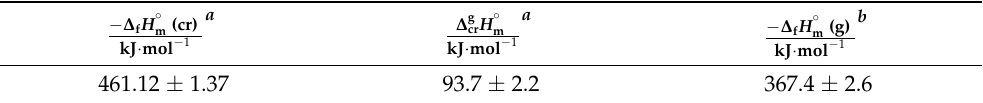
Table 7. Standard molar ( p ◦ = 0.1 MPa) enthalpies of sublimation, ∆ g cr H ◦ m , and of formation in